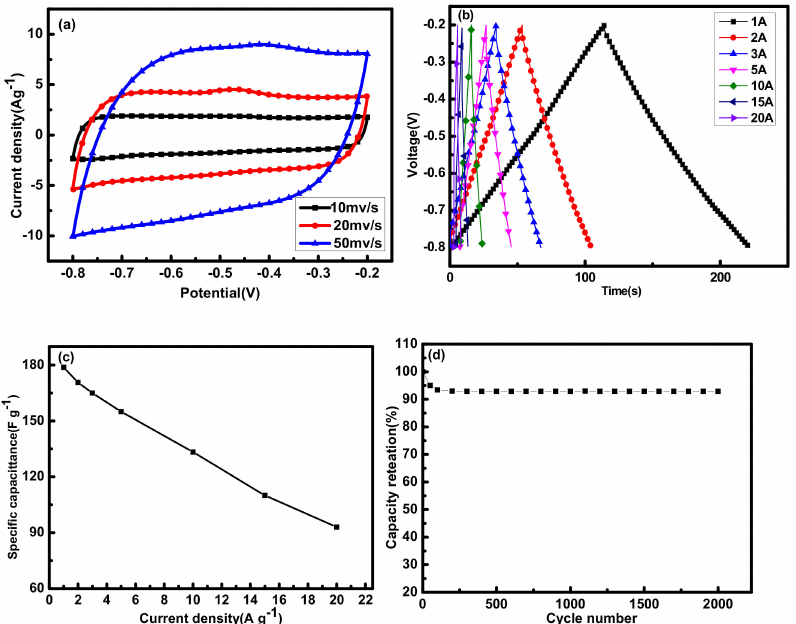
Figure 13. Electrochemical characterization of sample APCNs - 1.5: ( a ) CV curves of different scan rates; ( b ) Constant current charge and discharge curves with current density from 1 A g − 1 to 20 A g − 1 ; ( c ) Constant current charge and discharge line graph with current density from 1 A g − 1 to 20 A g − 1 ; ( d ) Specific capacitance retention rate from current density from 0.5 A g − 1 to 10 A g − 1